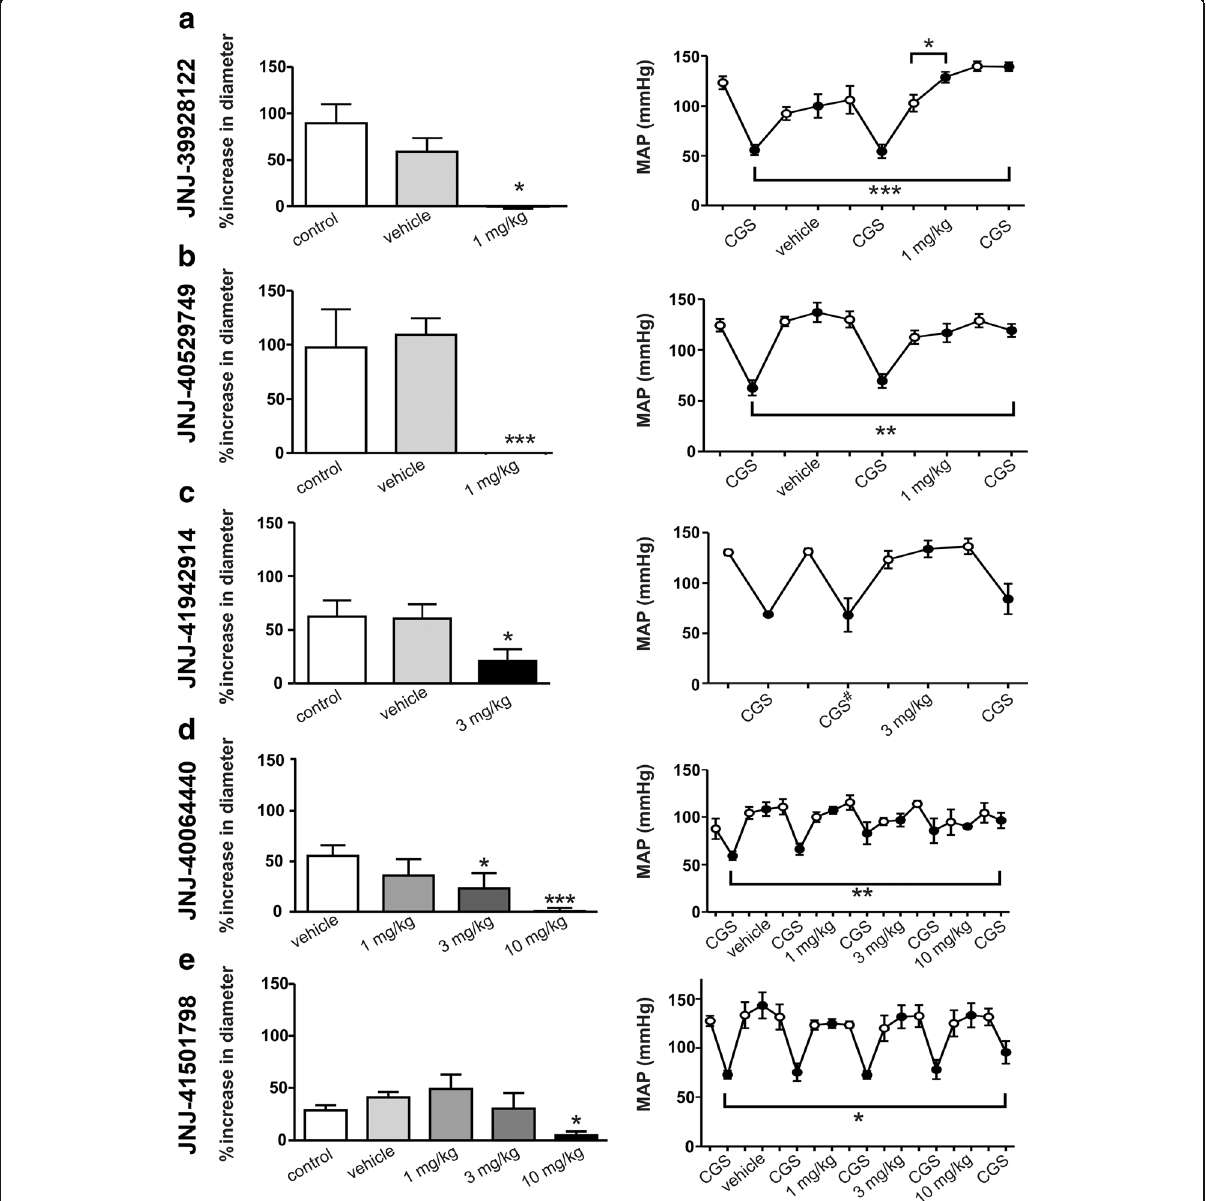
Fig. 4 Effect of i.v. CGS21680 on the dural diameter . CGS21680 (10 μ g/kg) was injected followed by an injection of vehicle and varying doses